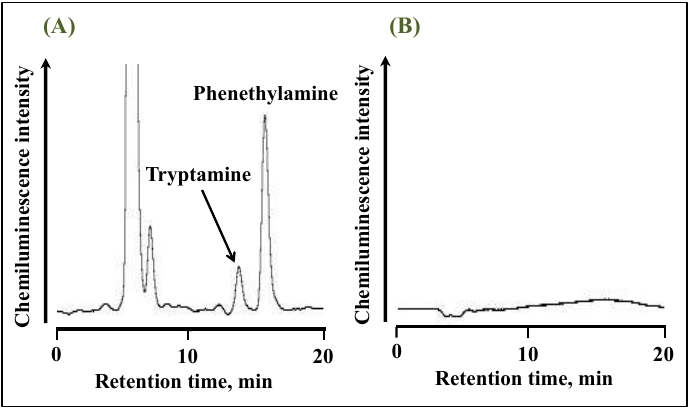
Figure 3. Chromatograms of 10 µM standard solution of tryptamine and phenethylamine after derivatization with anthraquinone-2-carbonyl chloride obtained ( A ) with and ( B ) without UV irradiation.